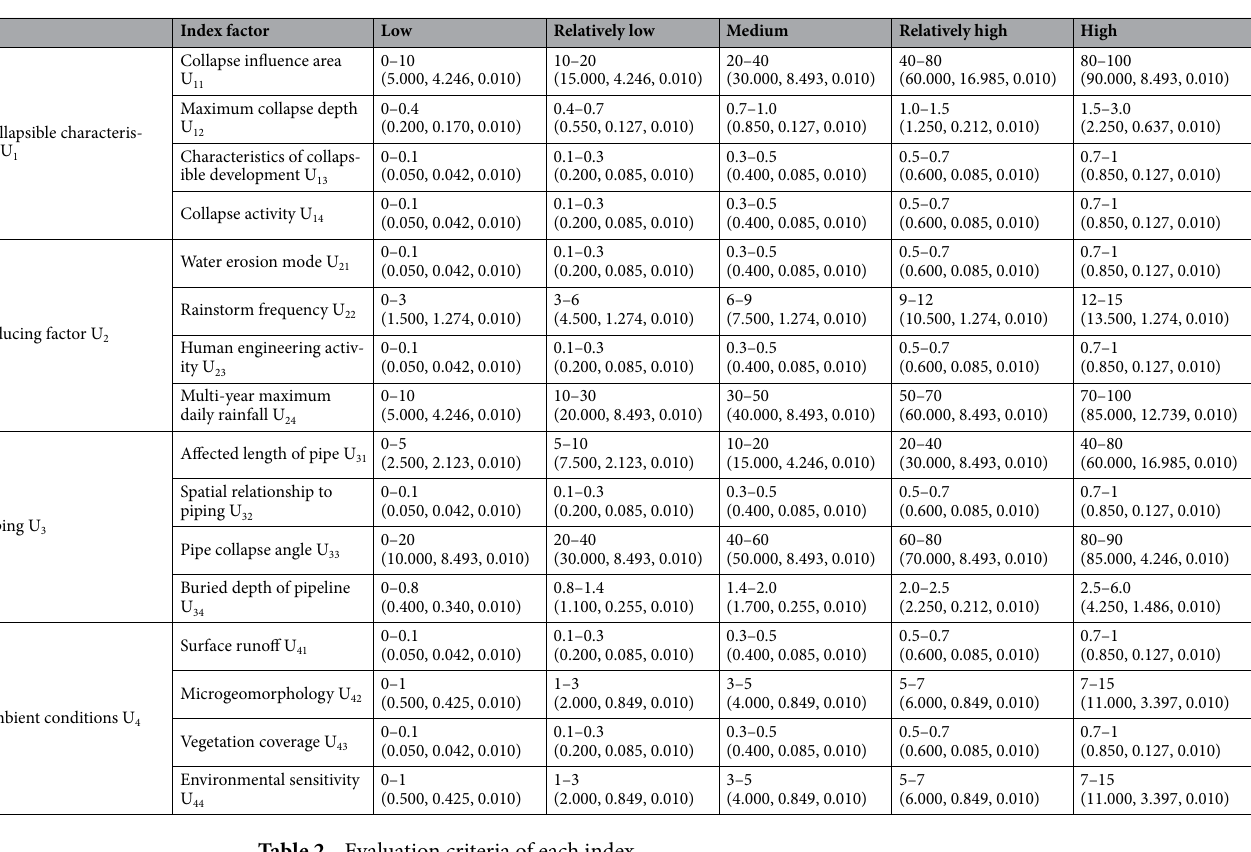
Table 2. Evaluation criteria of each